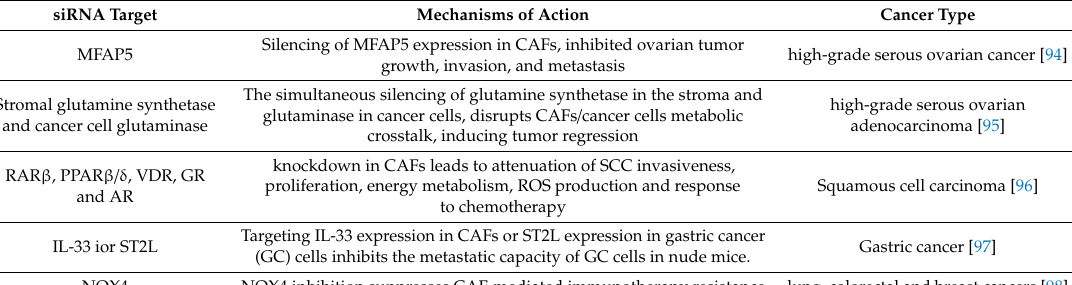
Table 3. Examples of small interfering RNAs (siRNAs) involved in the crosstalk between CAFs and tumor cells. siRNA